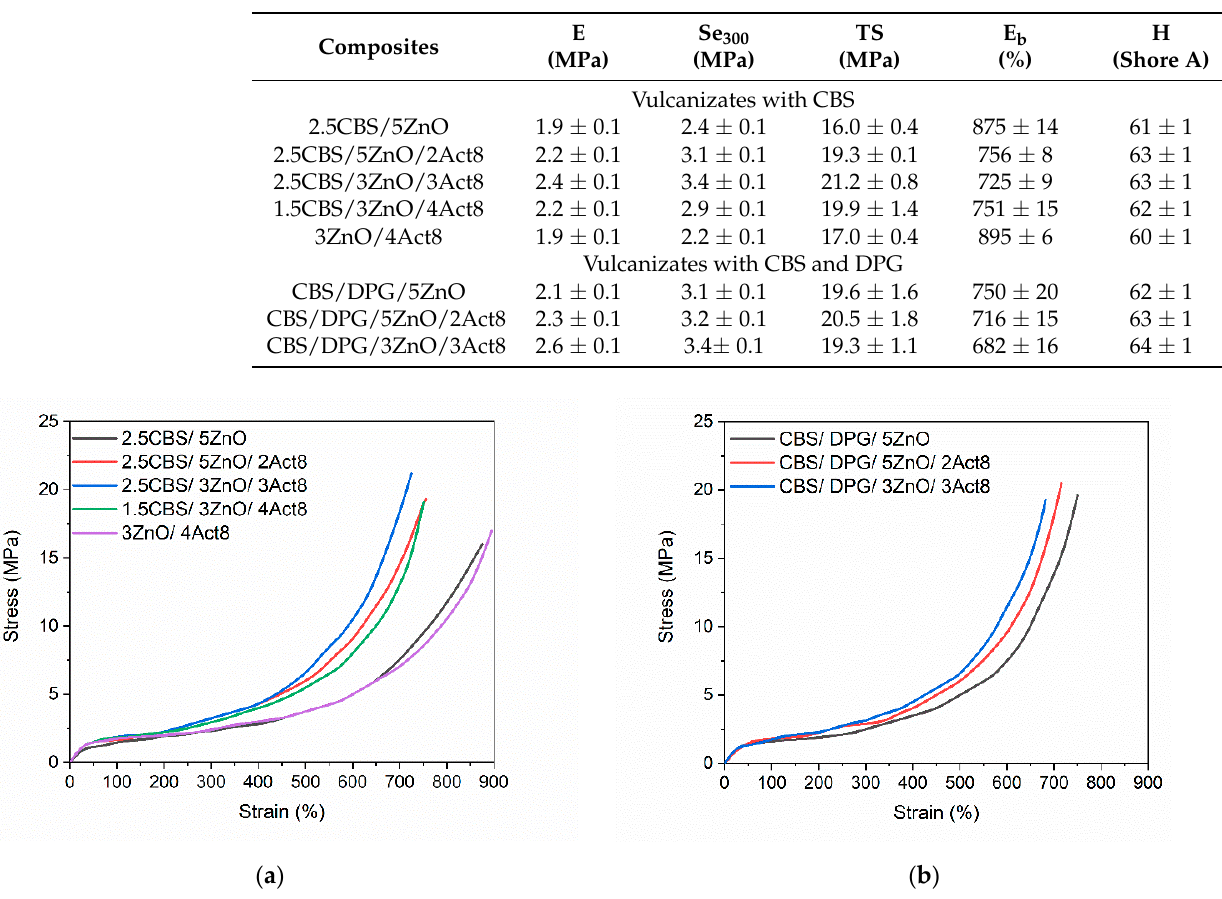
Figure 3. Stress-strain curves of SBR vulcanizates containing: ( a ) CBS; ( b ) CBS and